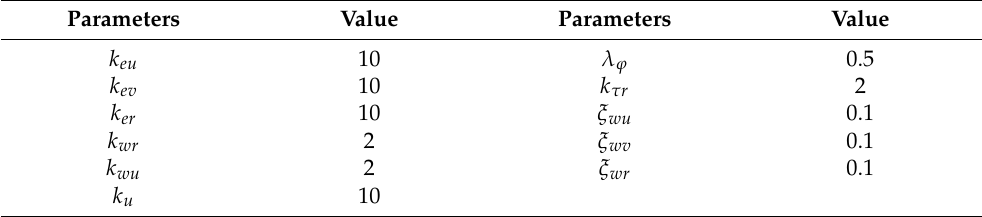
Table 2. USV control